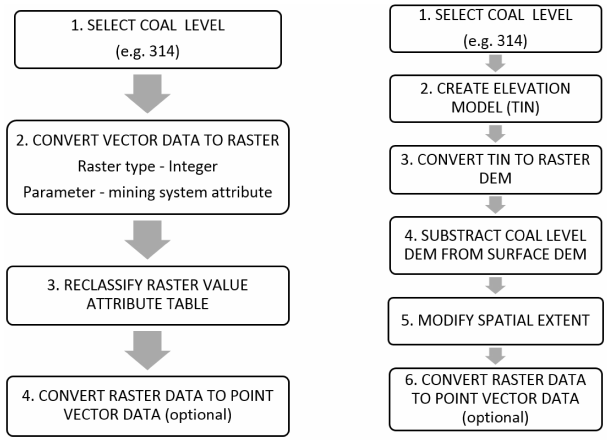
Figure 7. The simplified procedures to extract data for analyses, left – mining system variable, right – depth below the ground